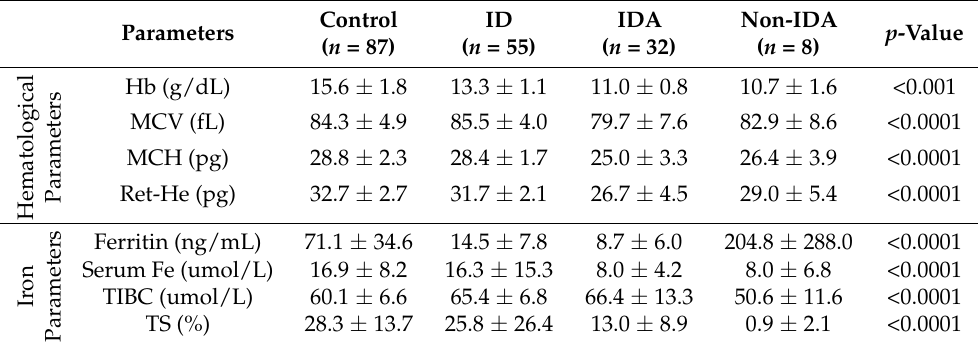
Table 2. Participants’ clinical findings.